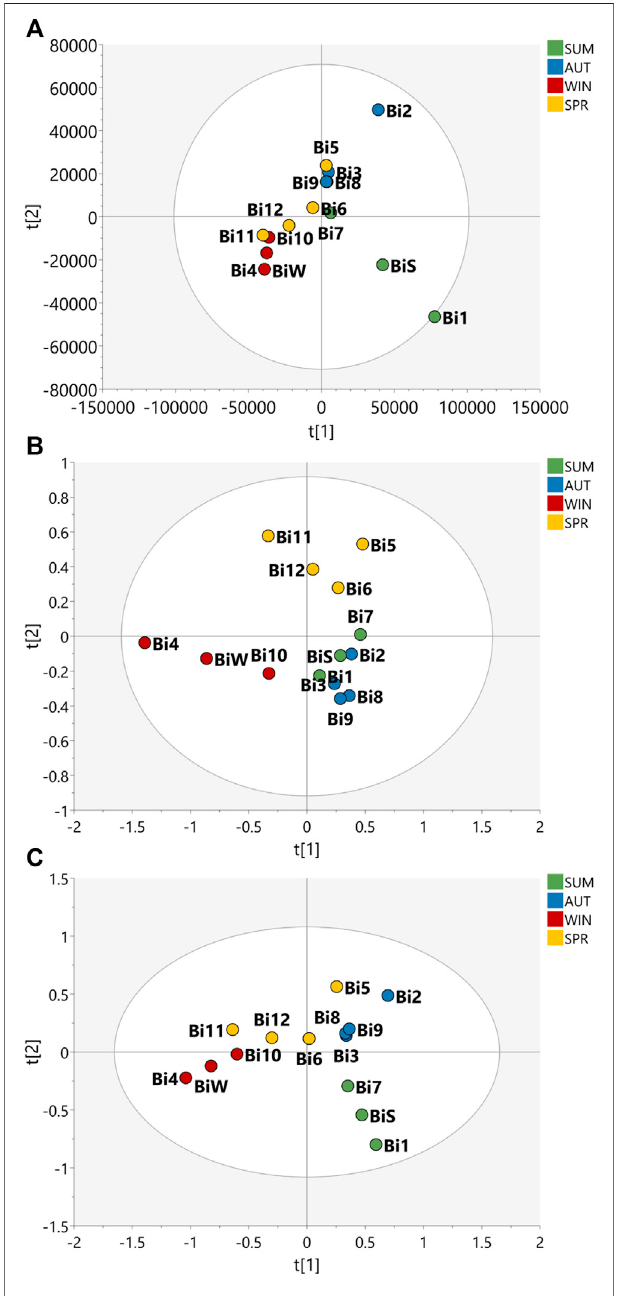
FIGURE 2 | Partial Least Squares Discriminant Analysis (PLS-DA) of the data acquired for the samples of the seasonal harvests of S. marginata . PLS- DA score scatter plot of (A) HRMS, (B) J -res NMR and (C) MS-NMR fused data of S. marginata extracts of summer (SUM), autumn (AUT), winter (WIN), and spring (SPR)